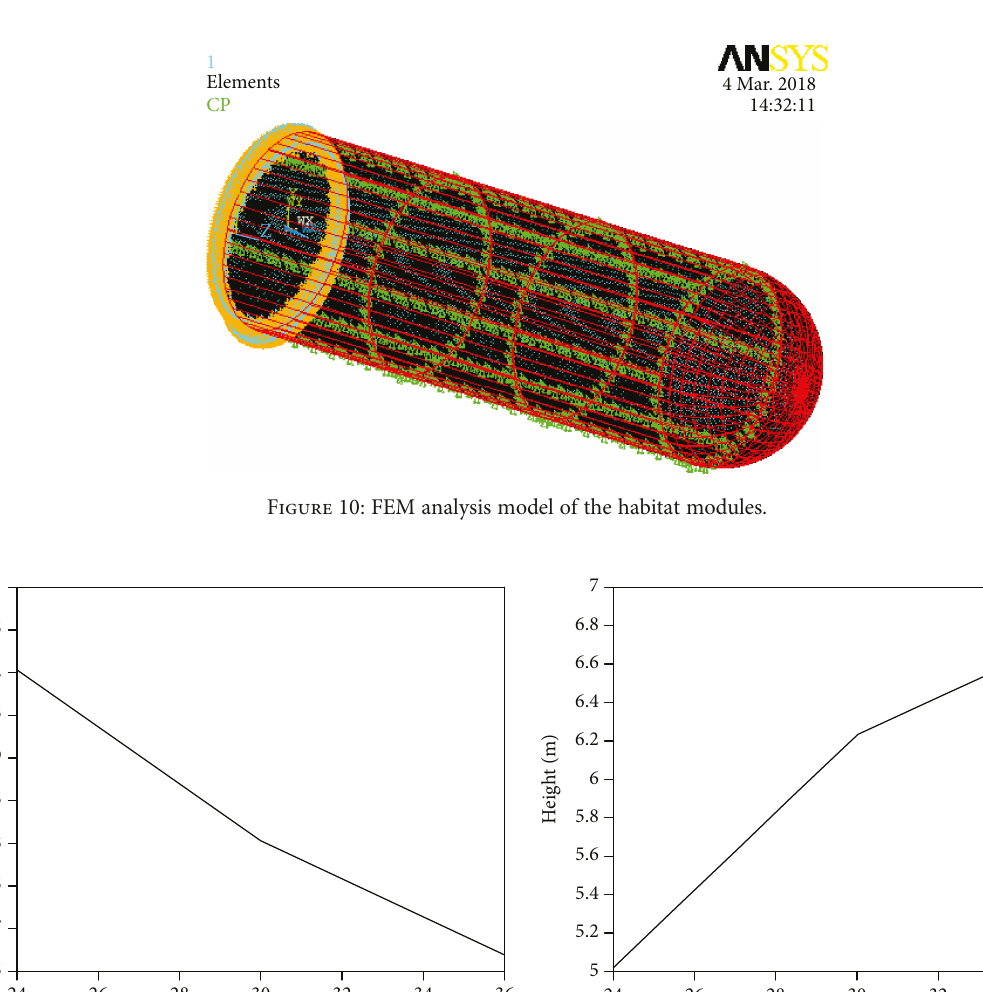
(b) The height of the folding state